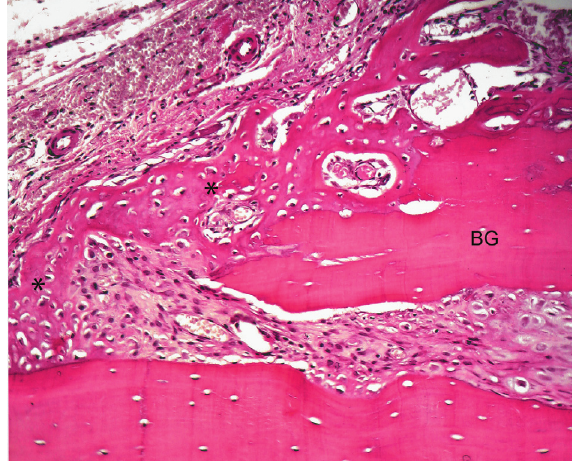
Figure 1- Group I – 10 days: Peripheral region of the graft. New bone formation, with primary bone tissue (asterisks), from the graft fragment (bone graft - BG) and parietal bone (hematoxylin-eosin – Original 160x)